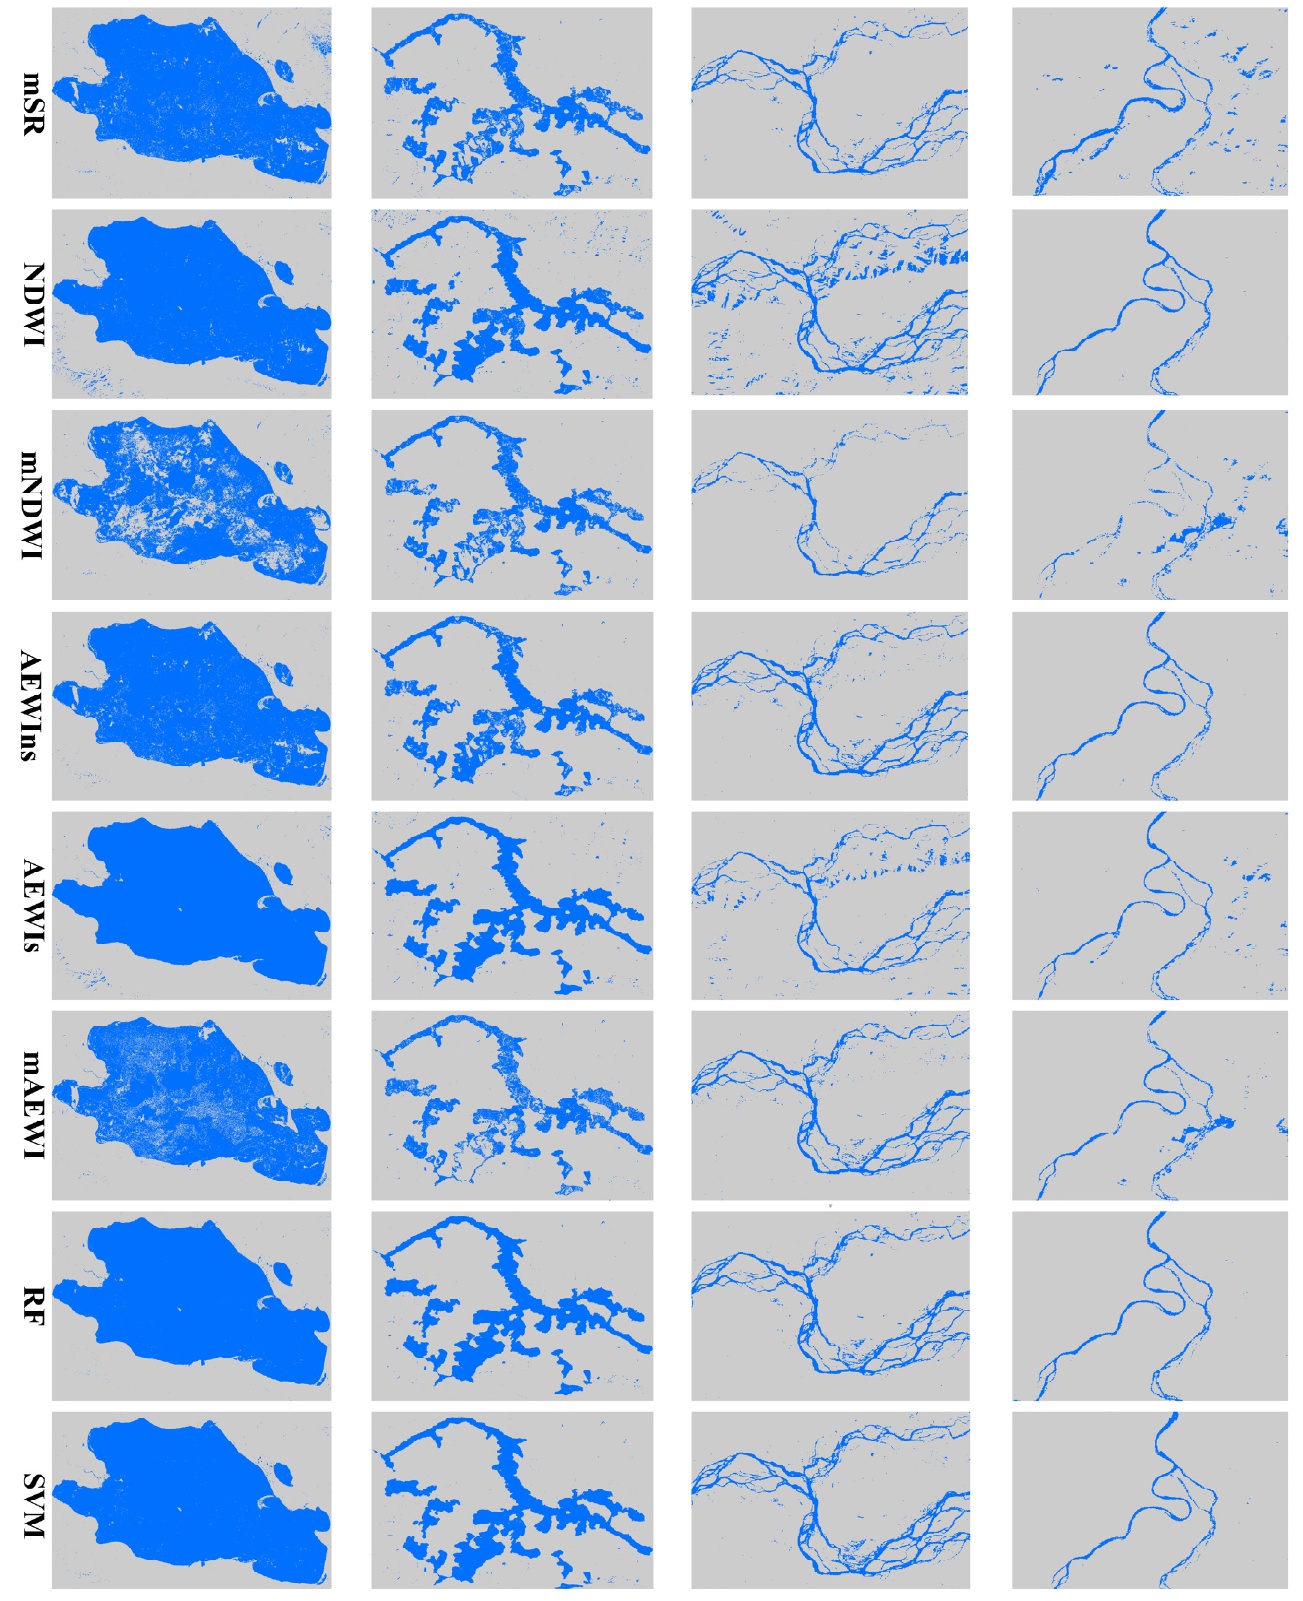
Figure 7. Comparison of the recognition accuracy of different water extraction algorithms for rivers and lakes. L9C2_SR imageries were synthesized in false color in bands 5, 4, and 3, and stretched with 2.5 standard deviations. The white oval circles on the image are the regions where the recognition abnormality may occur, which are A1, A2, A3, A4, A5, A6, A7, A8, and A9 from left to right.